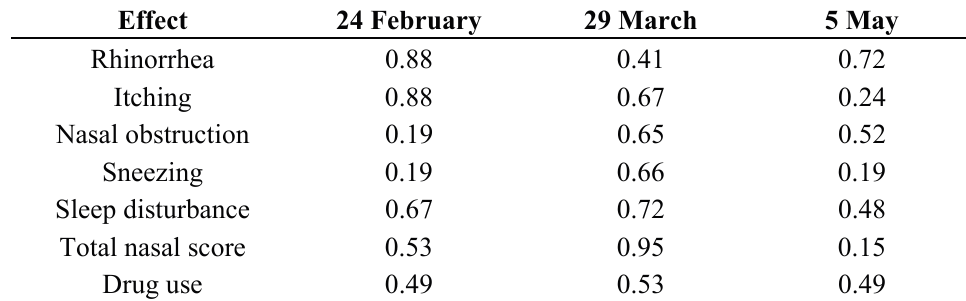
Table 6. The effects of PM 10 on allergy symptoms and drug use according to the short-term observations ( p